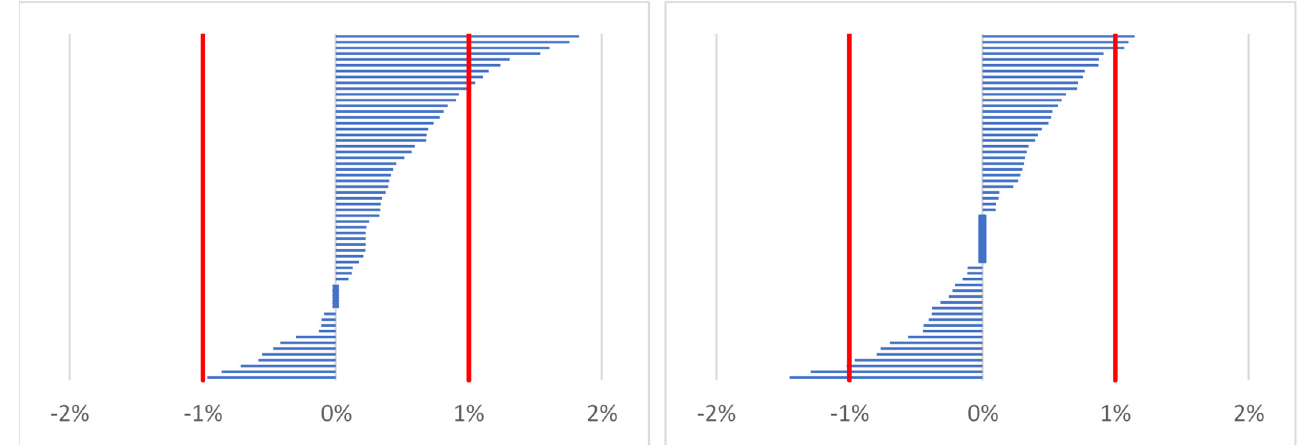
Figure 1. Distribution of changes in body mass for time point 2 (after work; on the left) and time point 3 (before work on the following day; on the right) vs. time point 1 (before work/baseline) in all participants ( n = 60).